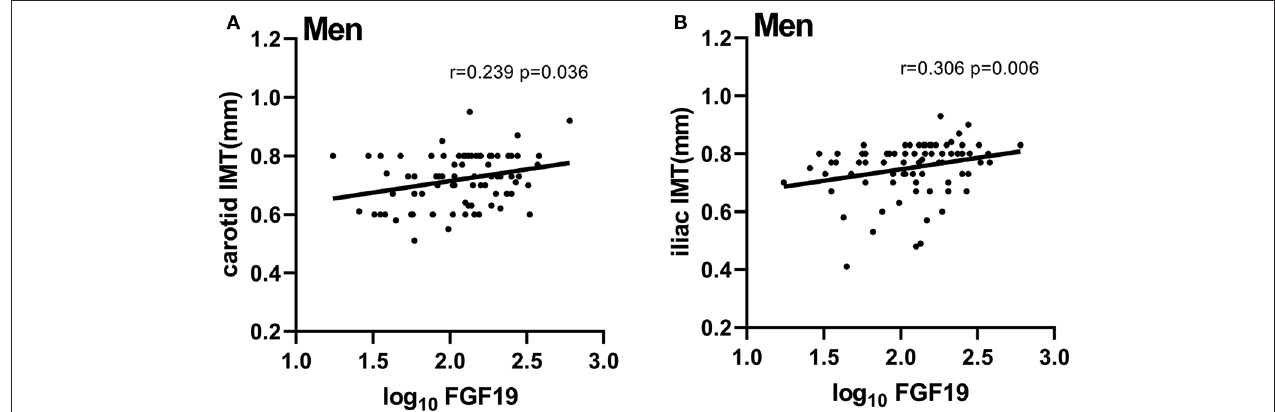
FIGURE 1 | Serum FGF19 levels were positively correlated with carotid IMT and iliac IMT in men. (A) Correlation of FGF19 and carotid IMT in men, carotid IMT = 0.07958 × log